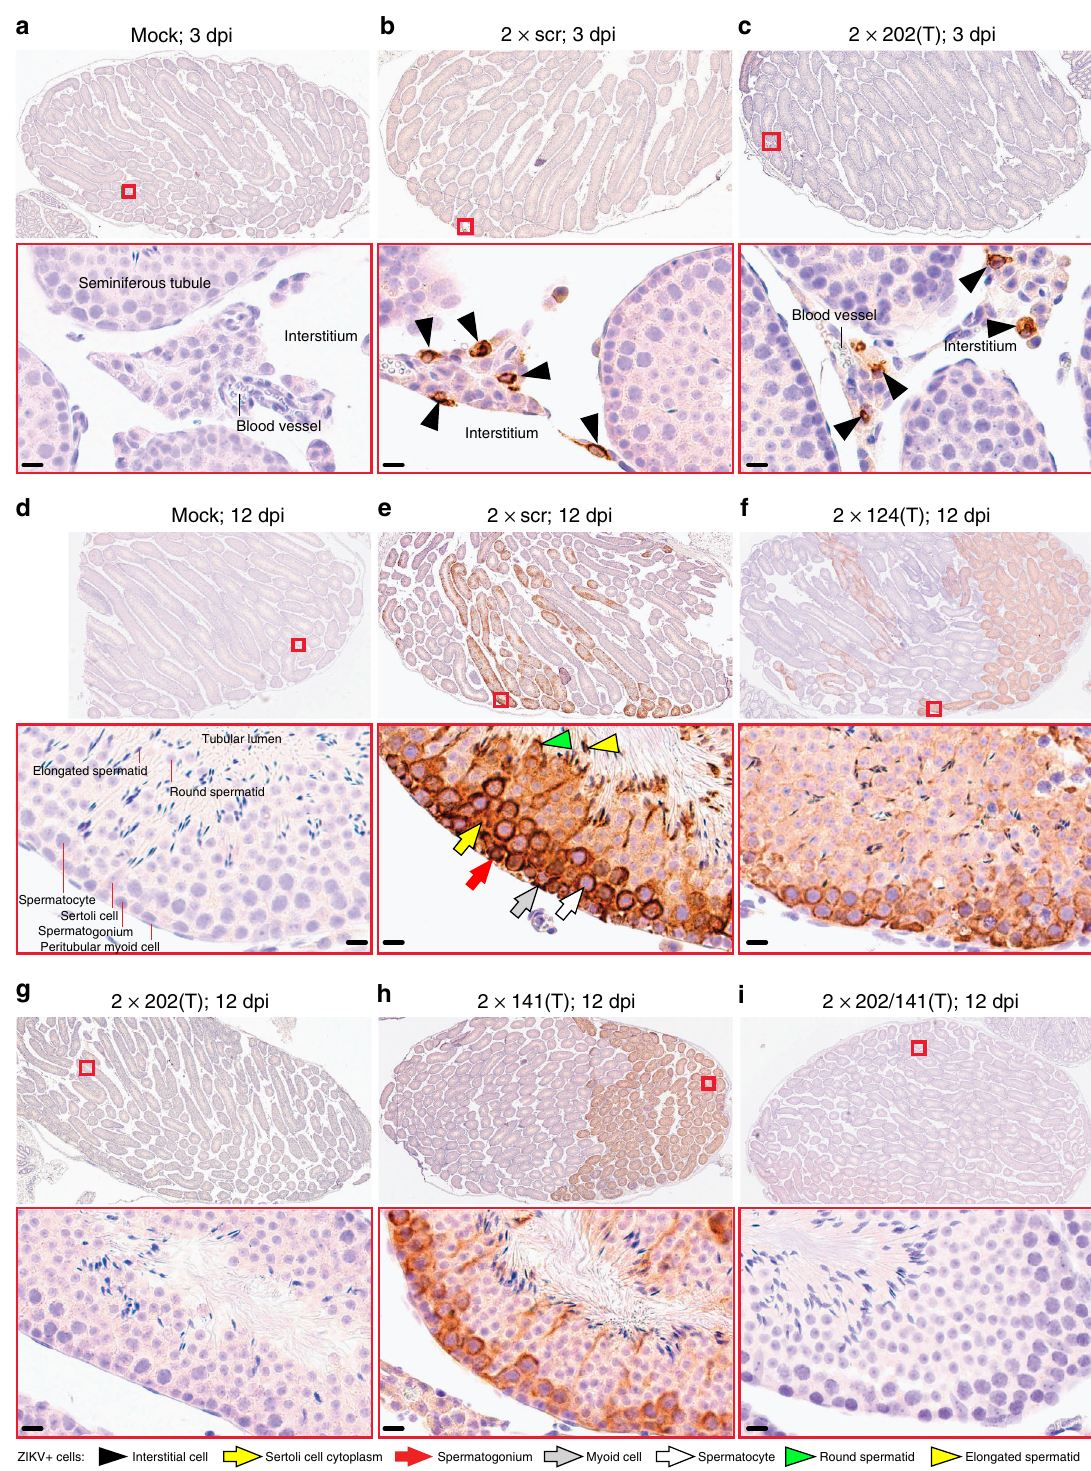
Fig. 3 ZIKV genome targeting for mir-202 – 5p restricts virus ability to infect cells of the seminiferous tubules. Adult AG129 mice were infected ip with 10 6 pfu of 2×scr, various miRNA-targeted viruses, or mock-inoculated and killed at 3 dpi a – c or 12 dpi d – i . Representative images of ZIKV antigen distribution in the testes of mice that were mock-inoculated or infected with indicated viruses are shown on the indicated dpi (2 – 6 mice per group). ZIKV antigen in a whole testis are shown in the top panel. Red boxes indicate the areas which are presented at higher magni fi cation images on the bottom of each panel. Testicular structural elements are indicated in a – c . The cellular elements of seminiferous tubules are indicated in d . Labeling used within panels is indicated at the bottom of the fi gure. Scale bars: 10 µ